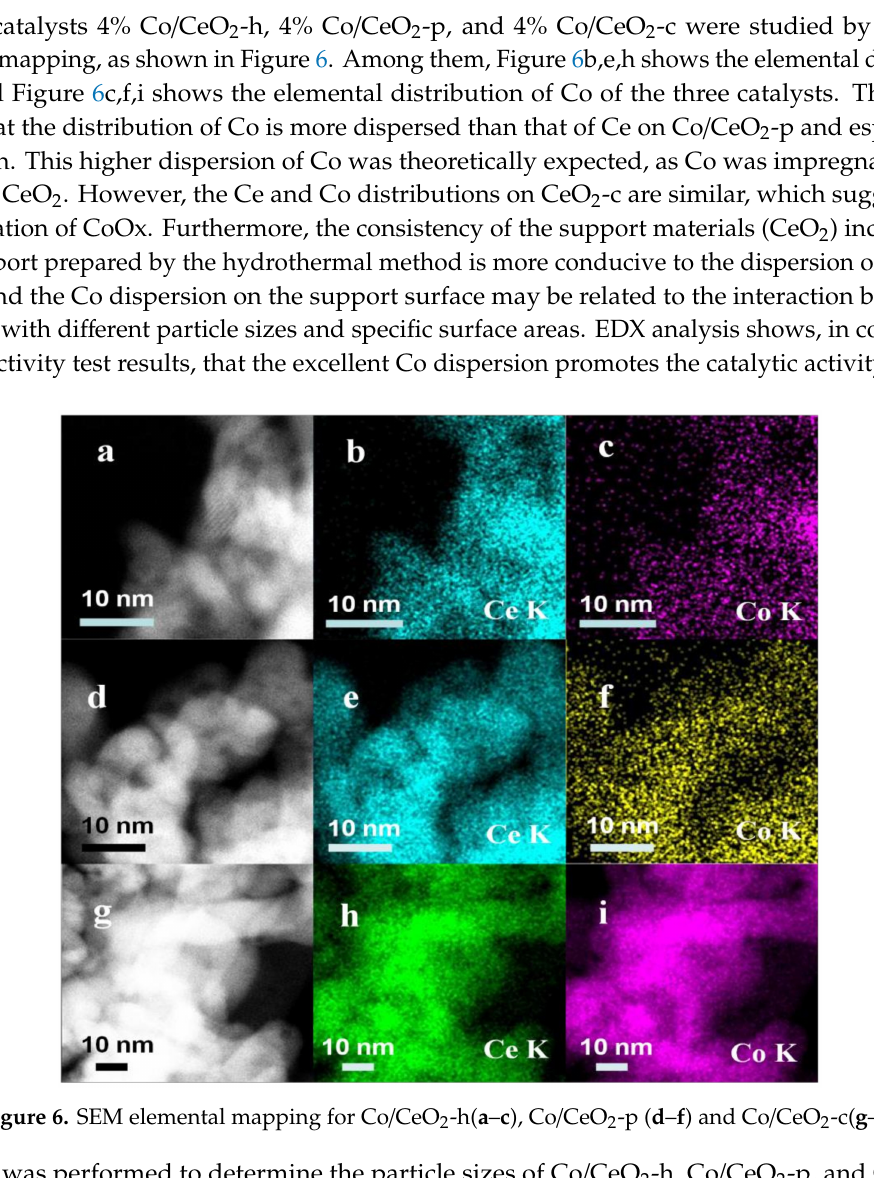
Figure 5. SEM images of 4% Co / CeO 2 catalysts.